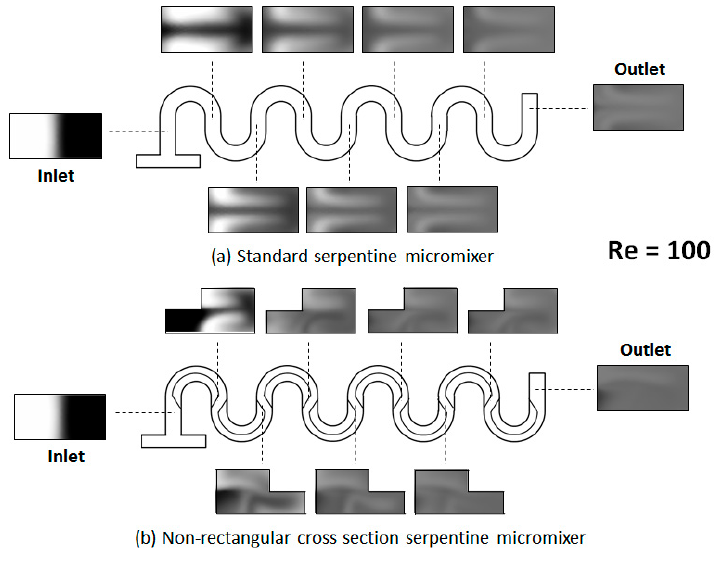
Figure 6. Transversal concentration distribution at various positions along the channel for ( a ) a standard serpentine micromixer and ( b ) a serpentine micromixer with a non-rectangular cross-section ( Re = 100).